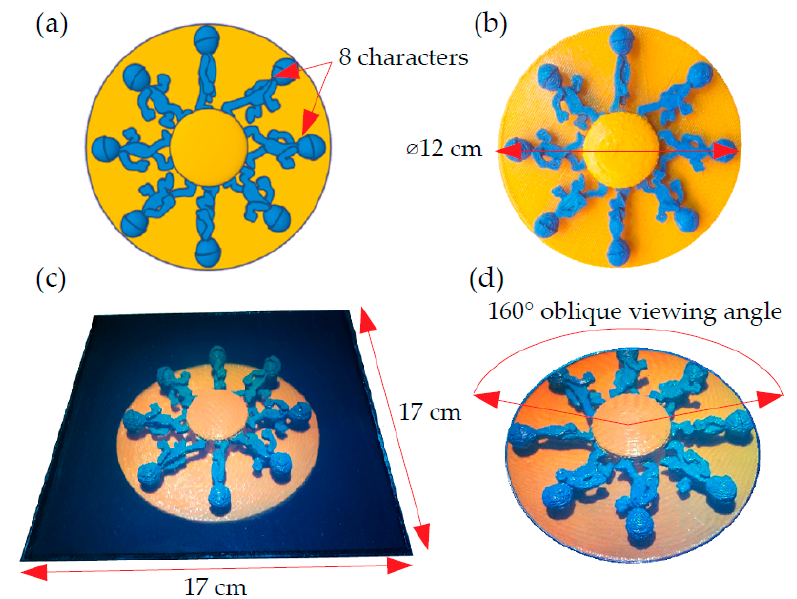
Figure 4. ( a ) Computer-generated model, ( b ) 3D printed and painted model, ( c ) H1 hologram, and ( d ) final floating